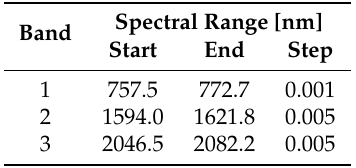
Table A2. Spectral